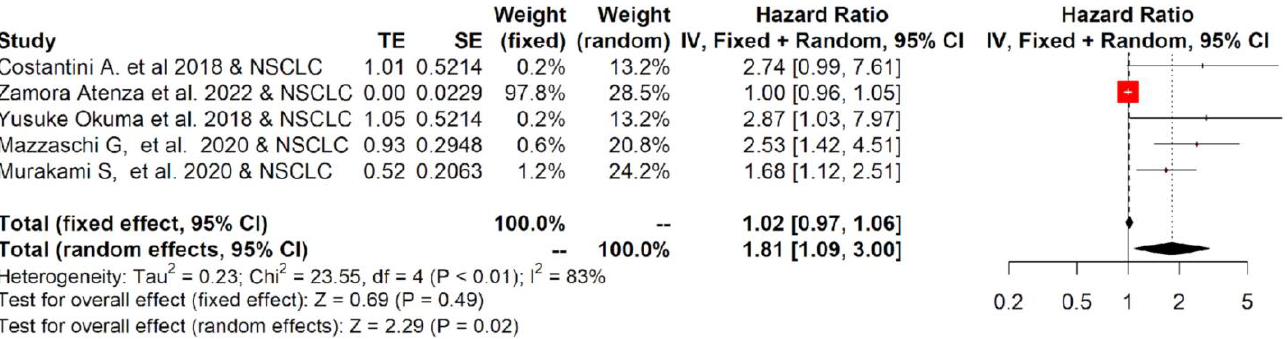
Figure 4. Overall pooled HRs comparing the high- versus the low-PD-L1 values group for OS in NSCLC patients treated with immunotherapy. The column study indicates the reference (from which we extracted or calculated the HR and 95% CI) and the investigated tumor type [22,23,25–27].